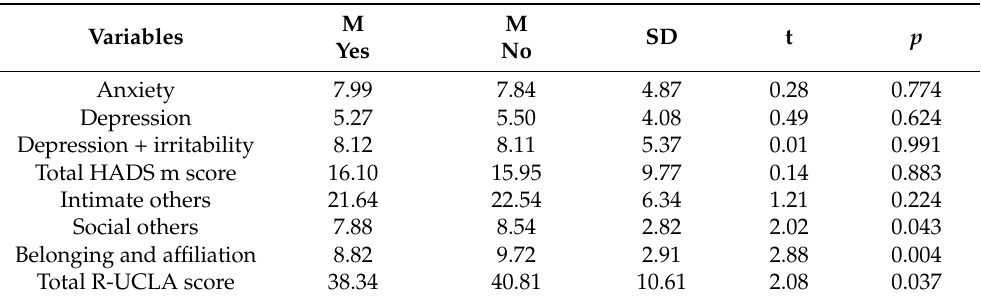
Table 7. Knowing someone with a positive test result for SARS-CoV-2 regarding HADS-M and R-UCLA